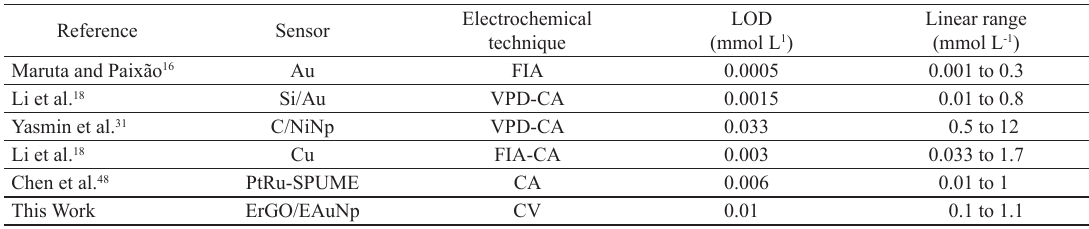
Table 2. Comparison of analytical parameters for the proposed method with other electrochemical methods found in the literature. Reference Sensor